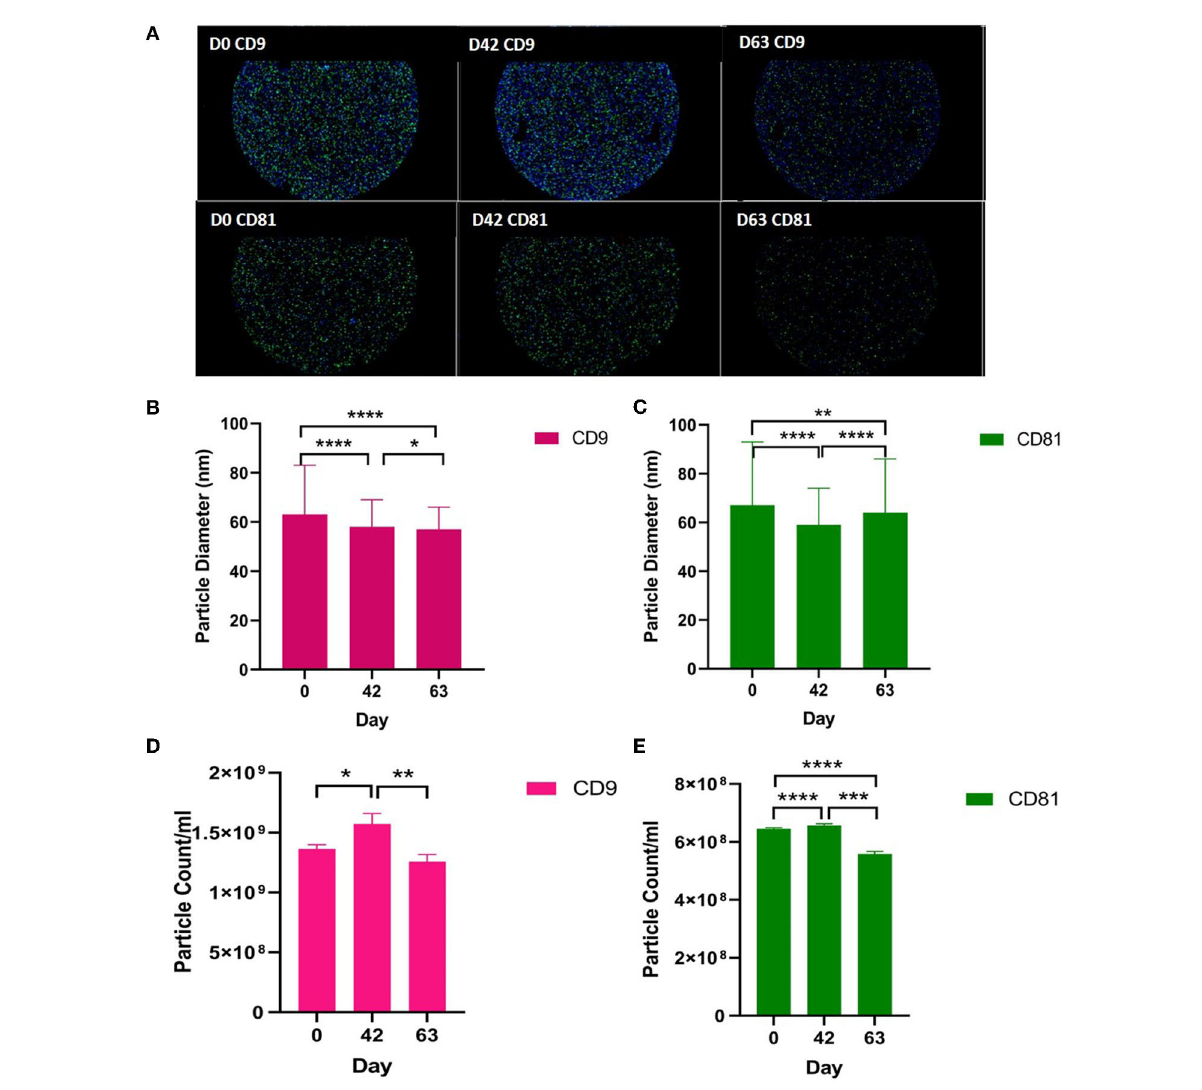
FIGURE2 Visualisation, sizing, and enumeration of plasma-derived EVs using Exoview at selected time points. All the data were adjusted for dilution of the sample onto the chip. Average of three technical replicates was run. Particle number was quantified by the number of particles in a defined area on the antibody capture spot. All bars are means and error bars standard deviation. Each sample represents a pool of all the four horses at prior to induction (day 0) and days 42 and 63 after the induction of OA. (A) Fluorescent image of a representative spot for each sample. (B,C) Sizing of (B) CD9- and (D) CD81-labelled EVs normalised to MIgG control. Limit of detection was 50–200nm. (D,E) Counting of CD9- and CD81-positive particles after probing with fluorescent tetraspanin antibodies. Statistical analysis was conducted in GraphPad Prism 9.0 by t -tests